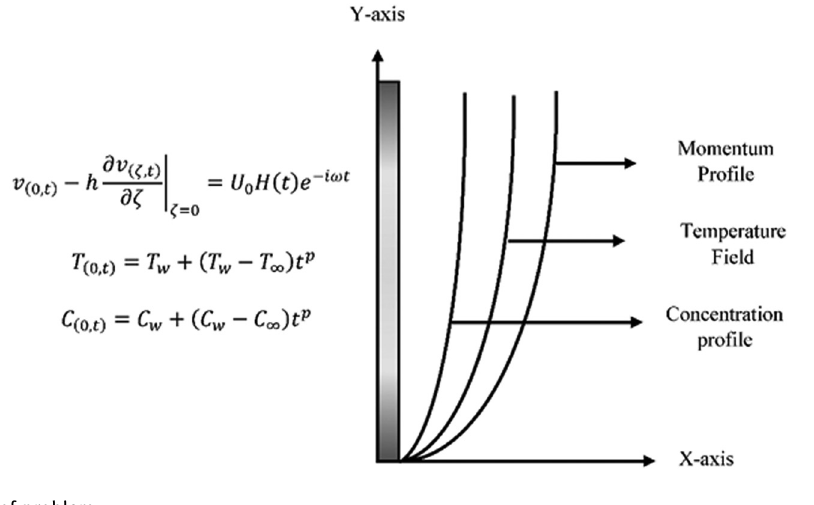
Figure 1: Physical fl ow of